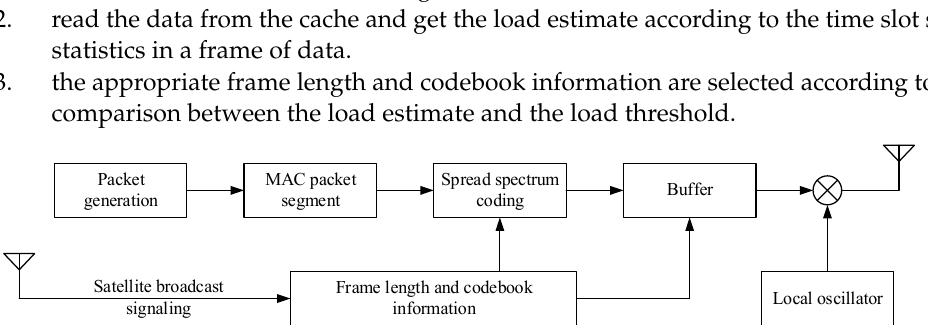
Figure 7. User-side architecture Figure 7. User ‐ side architecture design.